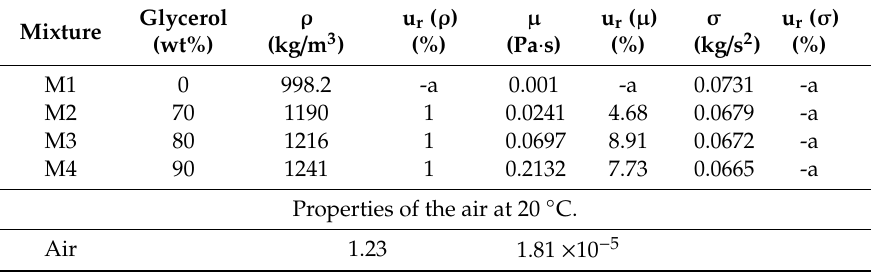
Figure 1. Schematic diagram of the fluid supply setup. Table 2. Rheological properties: density ( ρ ), viscosity ( µ ), surface tension ( σ ), and the corresponding uncertainty values u r ( γ ) of the tested aqueous glycerol solutions at 20 ◦